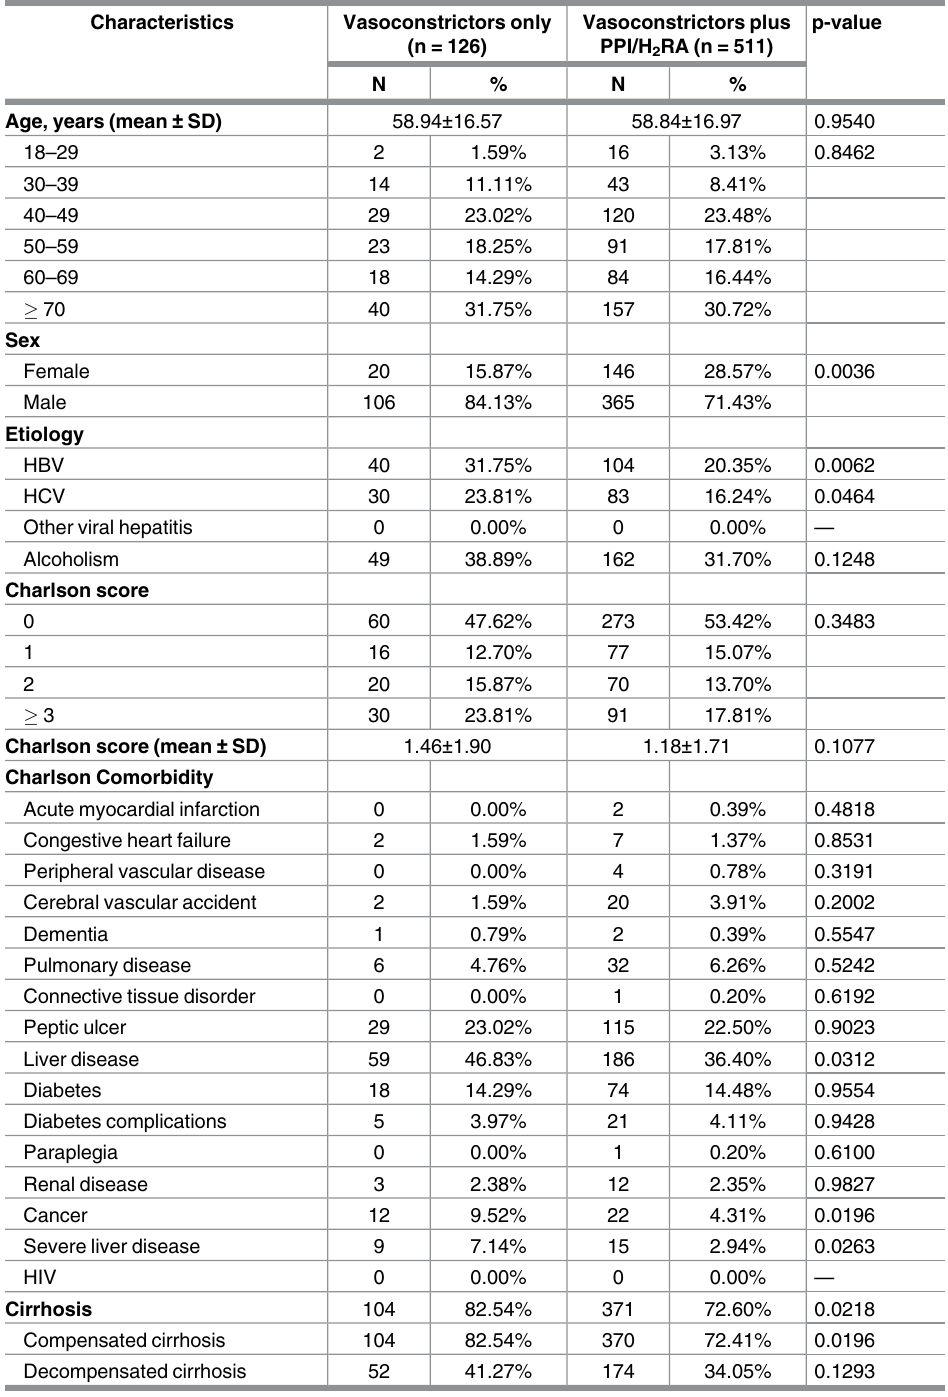
Table 1. Baseline